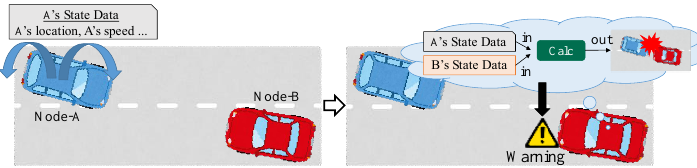
Figure 5. The procedures of CWS: broadcast to surrounding nodes and warn the users.